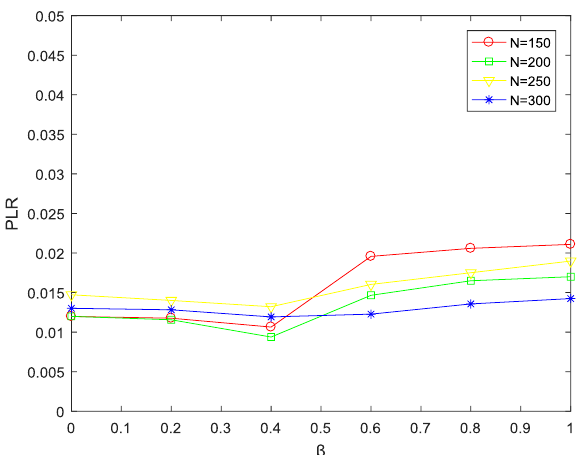
Figure 5. PLR varying with parameter β at different network sizes.